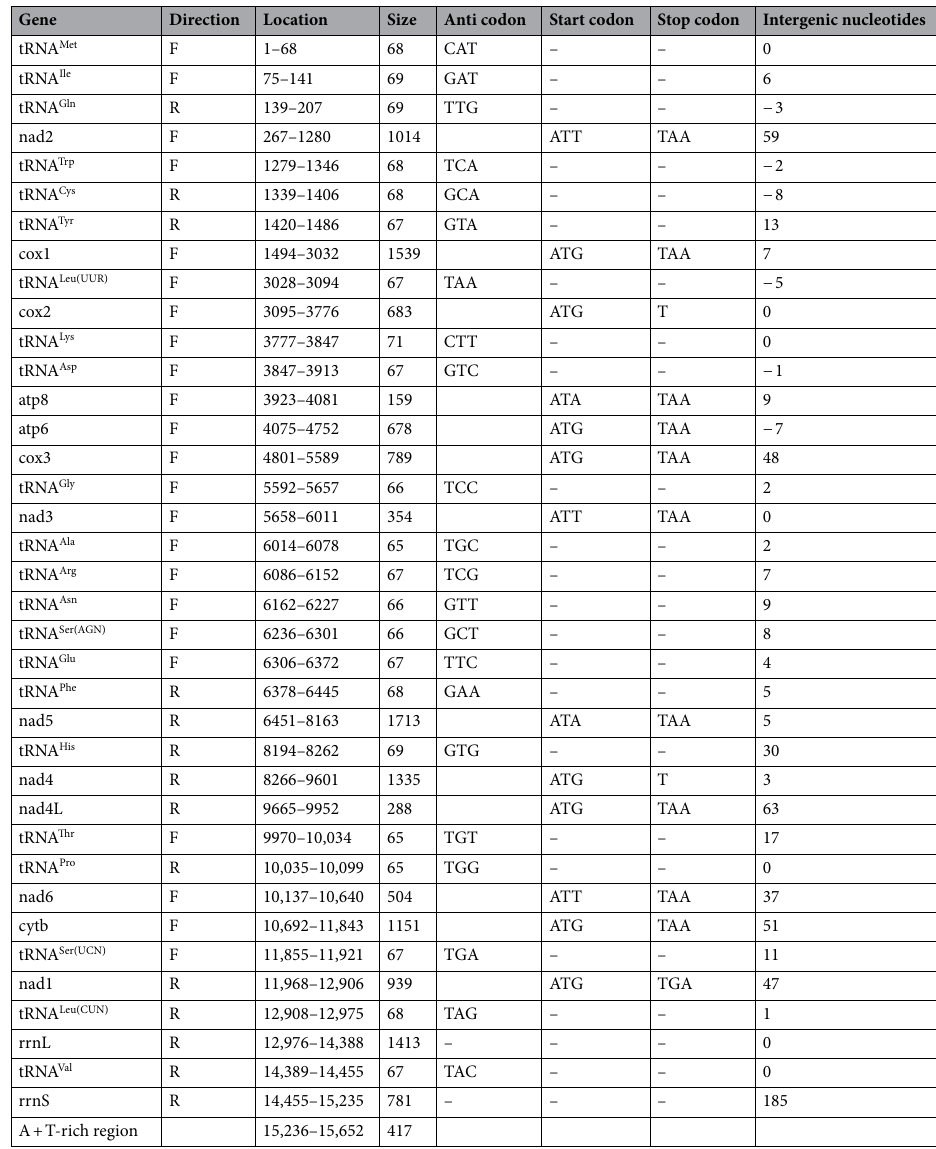
Table 1. List of annotated mitochondrial genes of S.